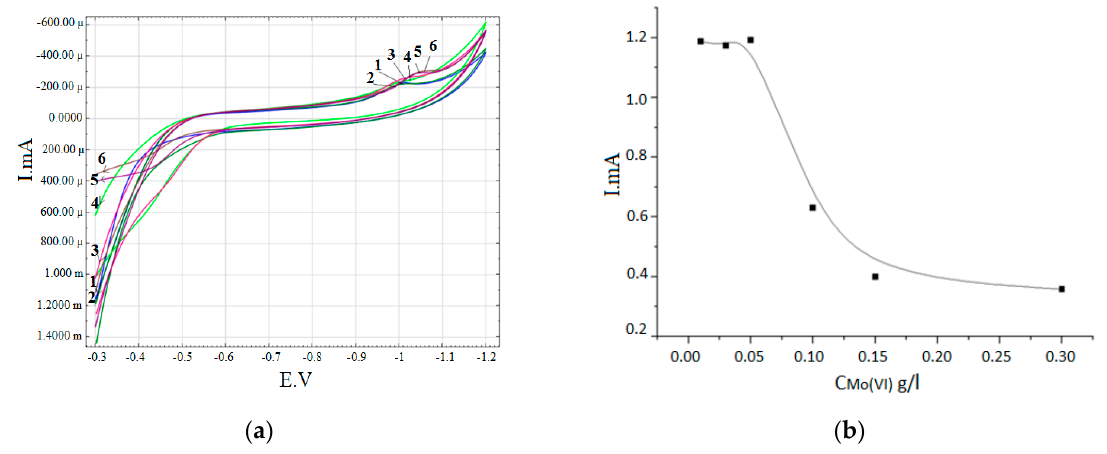
Figure 4. Volt–ampere curves of an iron electrode in 0.3 M Na 2 SO 4 + 0.2 g/L Zr (IV) + 0.15 g/L W (VI) ( a ) and a change in